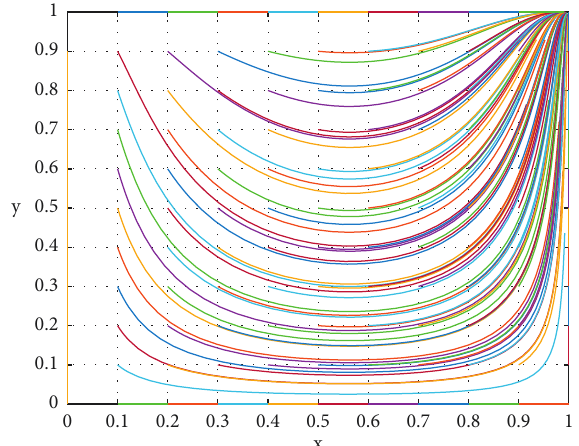
Figure 12: Evolution path when ηβ < μ < α and ε < ηβ − α < 0.